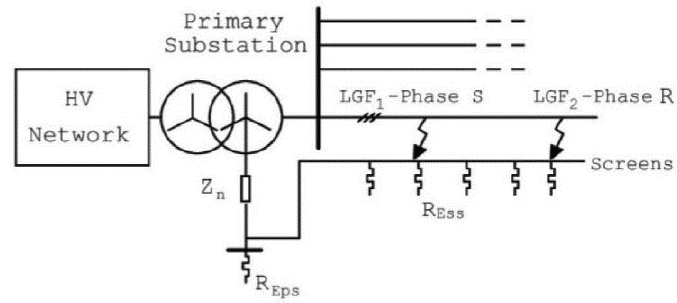
Figure 5. Single line diagram of a MV distribution network with CCF in the same cable line.